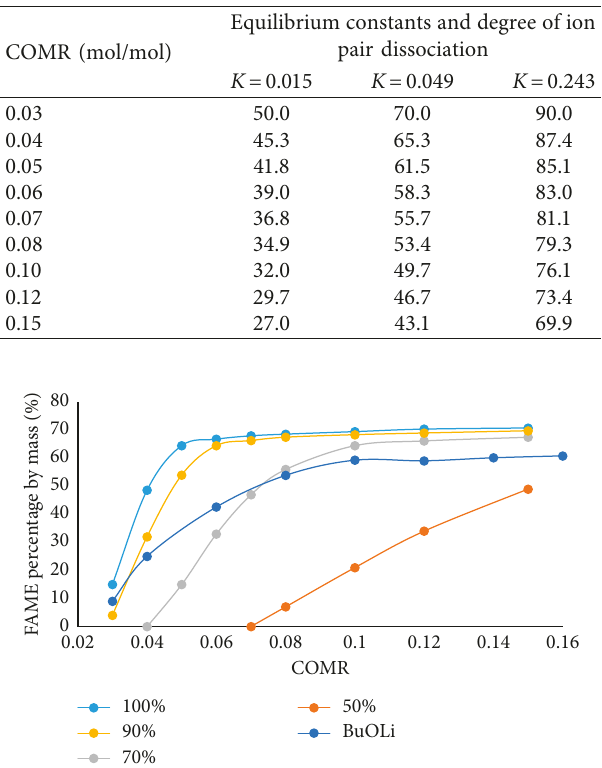
Figure 3: Plots of FAME percentage by mass, obtained by the simulation of the tert -butoxide ion pair formation versus COMR.